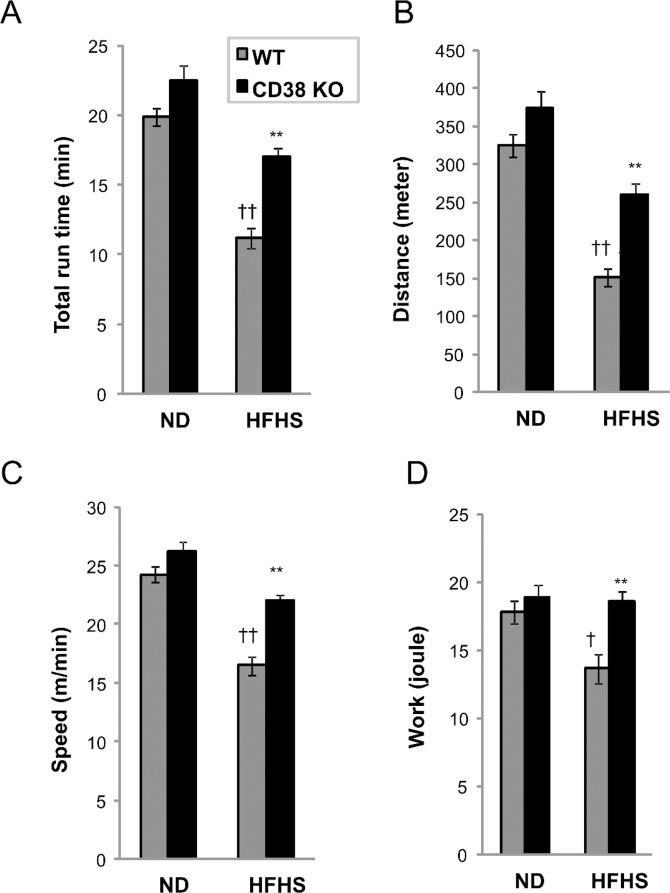
CD38 KO mice are protected from western diet-induced exercise intolerance.(A-D) Treadmill running to exhaustion was performed with WT (grey) and CD38 KO (black) mice fed a ND or HFHSD for 5 months before the study. N = 8 per group. †, p value<0.05 (ND vs HFHS); ††, p value<0.01 (ND vs HFHSD); **, p value<0.01 (WT vs KO). See Material and Methods for experimental details.